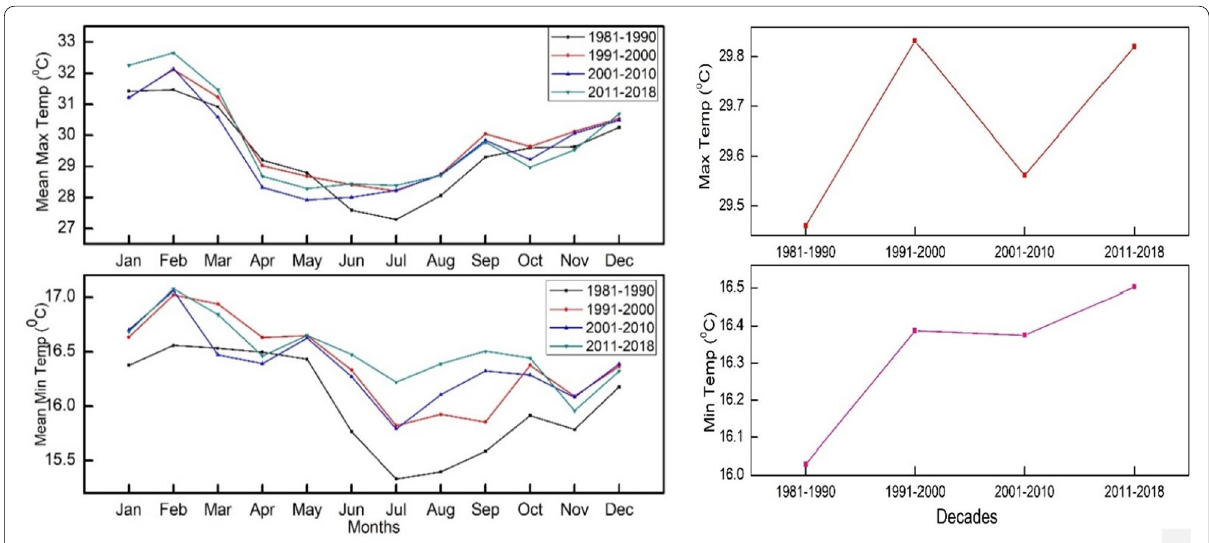
Fig. 13 Decadal mean Tmax and Tmin in semi-arid Borana